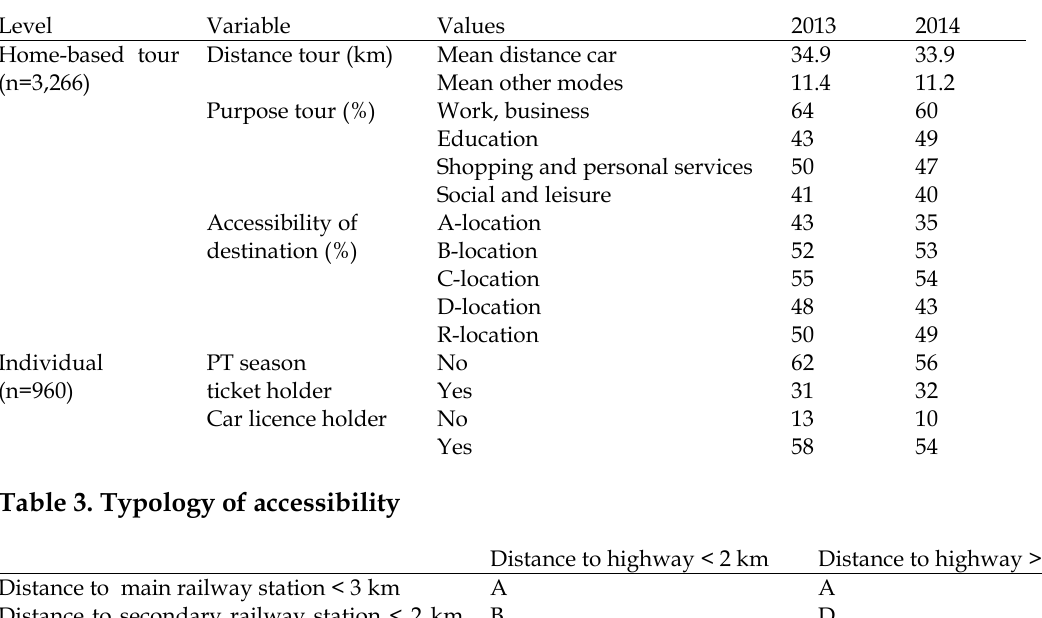
Table 2. Car use by tour and individual characteristics